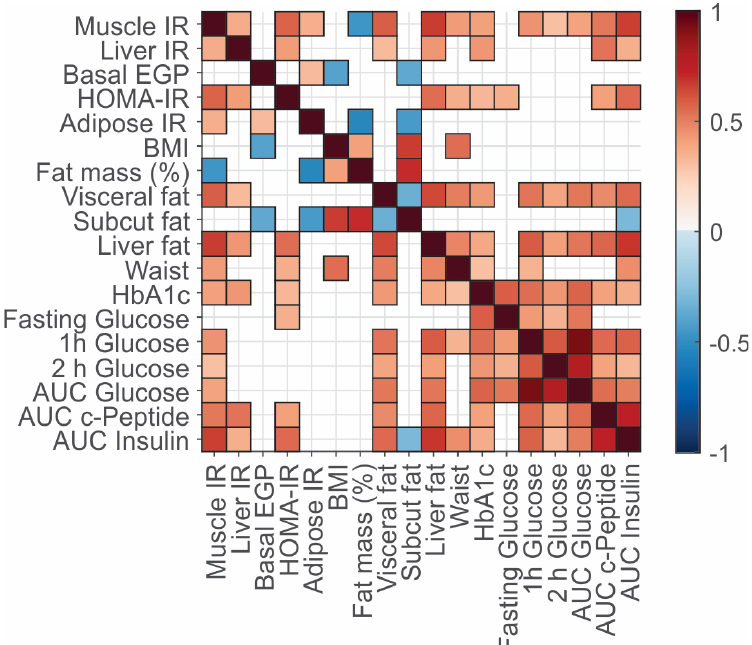
Figure 1. Spearman correlations between the clinical characteristics. The correlations are shown as a heatmap with the color indicating the significance and direction of the correlation (Spearman) (i.e., red positive, blue negative). Only the significant correlations are shown, where the p ‐ value cut ‐ off for significance ( p = 0.025503) was determined using the Benjamini–Hochberg correction. Note the full correlation of the variables with themselves along the diagonal. Complete data were available for all variables other than the abdominal MRI data ( n = 59) and AUC of insulin and c-peptide ( n = 57 and n = 59, respectively).